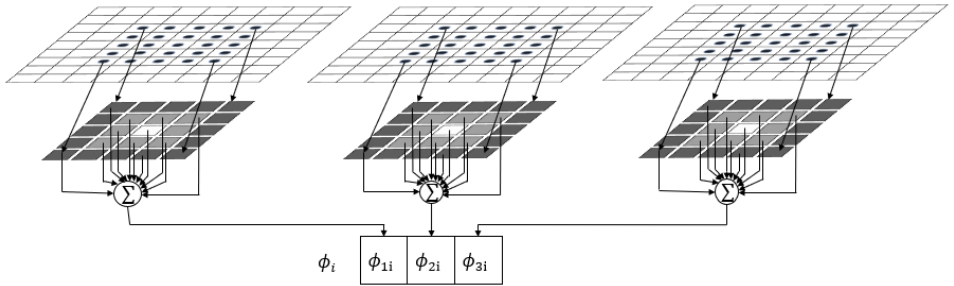
Figure 4. The calculation process of weight vector φ i for three classes. In this example, the neighborhood size is specified as 5 × 5.